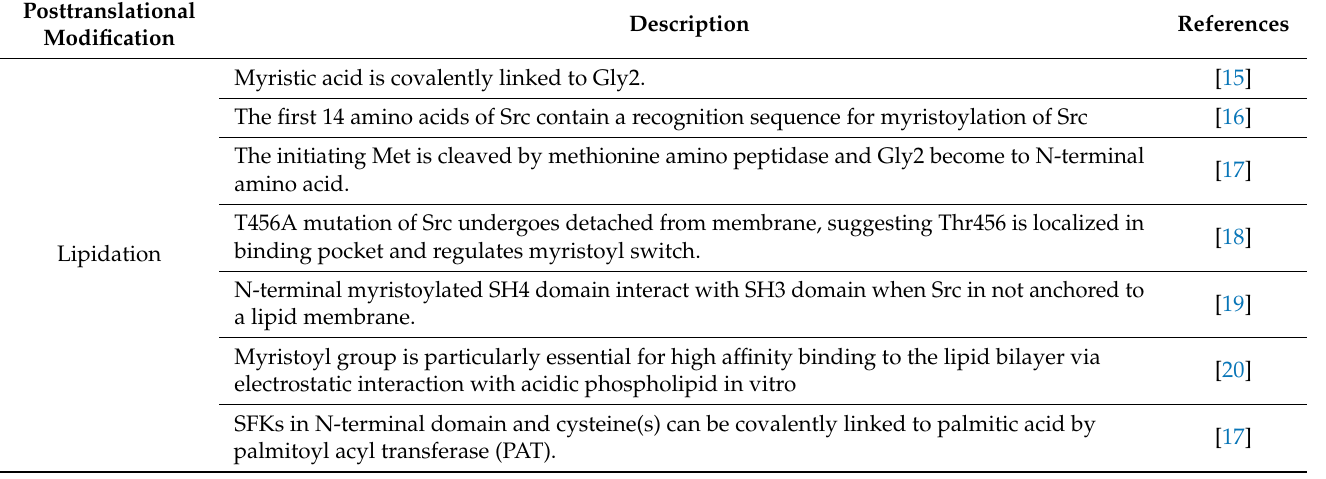
Table 1. Post-translational modifications of